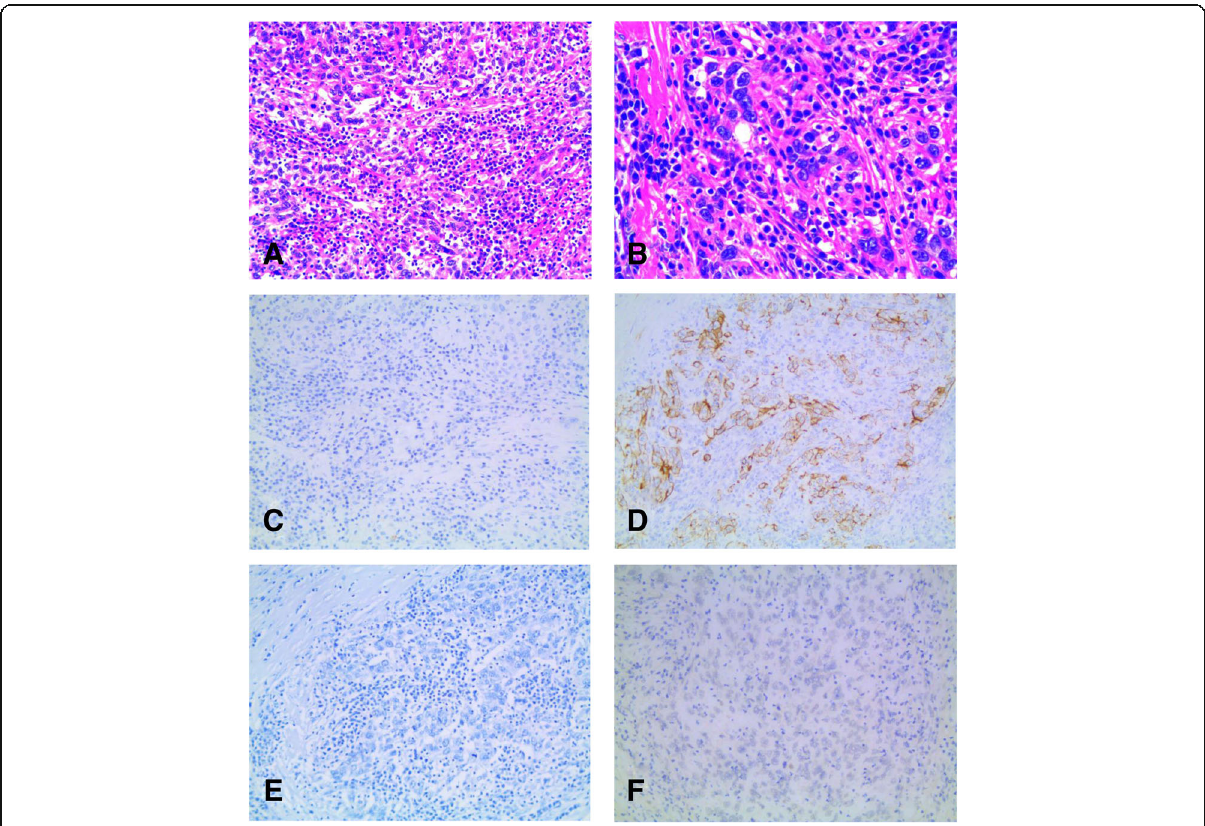
Fig. 3 Microscopic findings of the resected specimen. The tumor composed of poorly differentiated epithelial cells with vesicular nuclei, prominent nucleoli and intense lymphocytic infiltration. ( a , HE, × 200), ( b , HE, × 400). Immunohistochemical staining for hepatocyte is negative ( c , HE, × 200). Immunohistochemical staining for CK18 is positive ( d , HE, × 200). Immunohistochemical staining for Arg and EBER is negative ( e , HE, × 200), ( f , HE, ×